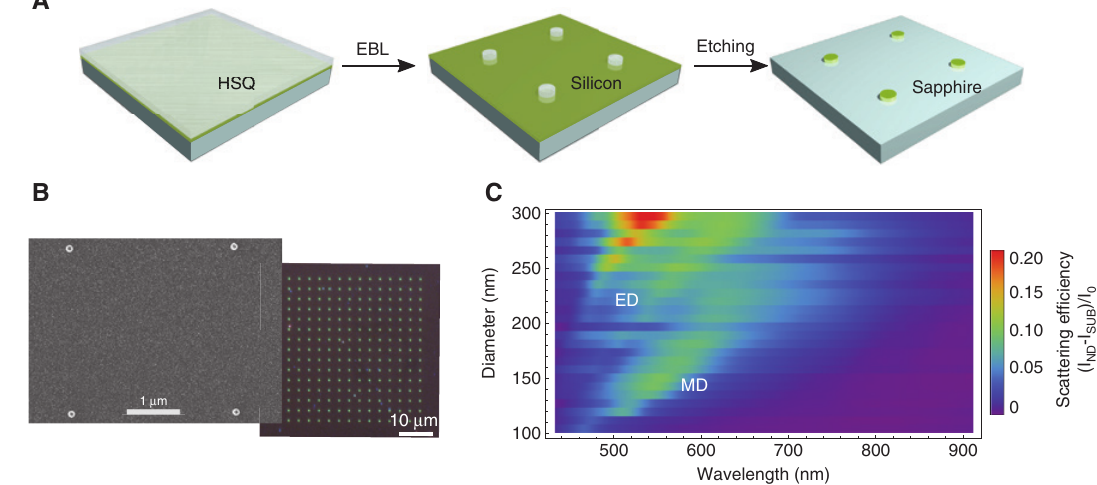
Figure 2: Nanofabrication and optical characterization of silicon nanodisks. (A) Sketch of the nanofabrication procedure. Hydrogen silsesquioxane (HSQ) was used as an electron-beam resist for electron-beam (B) Scanning electron micrograph and dark-field optical image of typical fabricated structures arranged in a 3 μ m pitch, with 110 nm